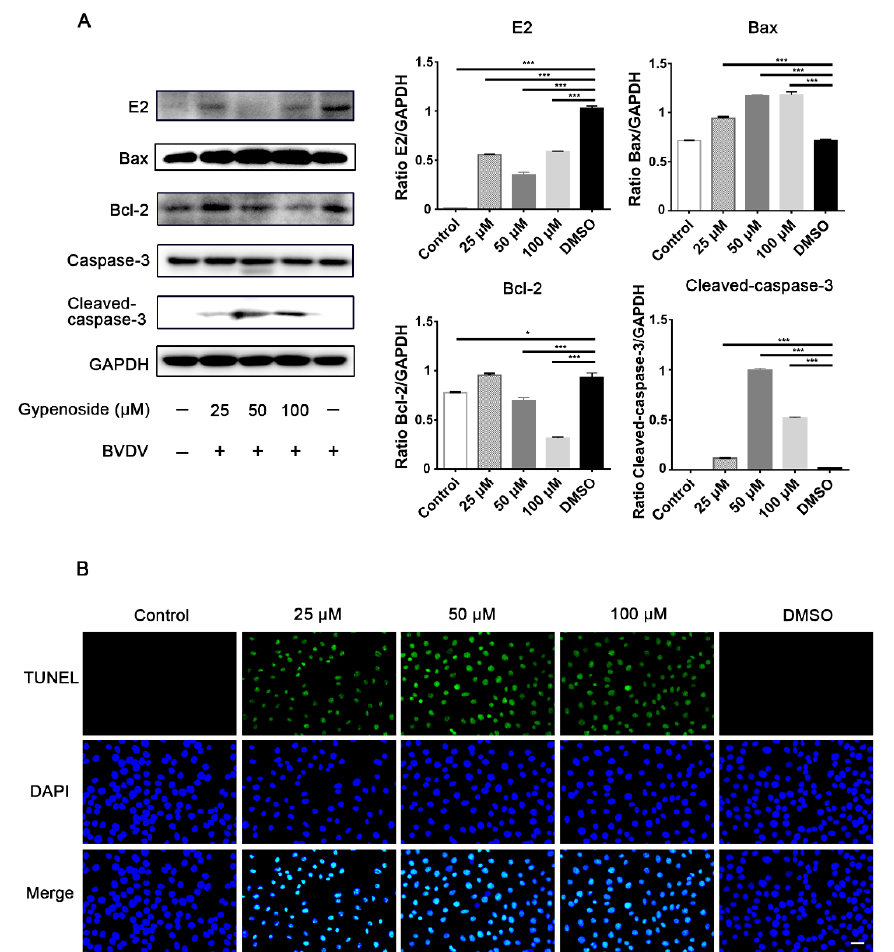
Figure 5. Gypenoside promotes BVDV-inhibited apoptosis in MDBK cells. ( A ) Western blotting analysis of BVDV E2, Bax, Bcl-2, and cleaved caspase-3 proteins in BVDV-infected MDBK cells treated with the indicated concentrations of gypenoside at 24 hpi. The protein bands were quantified as the ratio of the intensity of the protein bands to that of the GAPDH band in Western blotting. ( B ) TUNEL staining to assess the effects of the indicated concentrations of gypenoside on apoptosis in BVDV-infected MDBK cells at 24 hpi. TUNEL (green) and DAPI (blue). Scale bars represent 100 μ m. The merging represents the co-localization of green and blue staining. Data from three independent experiments and error bars are presented as the mean ± SEM. * p < 0.05, *** p < 0.001.